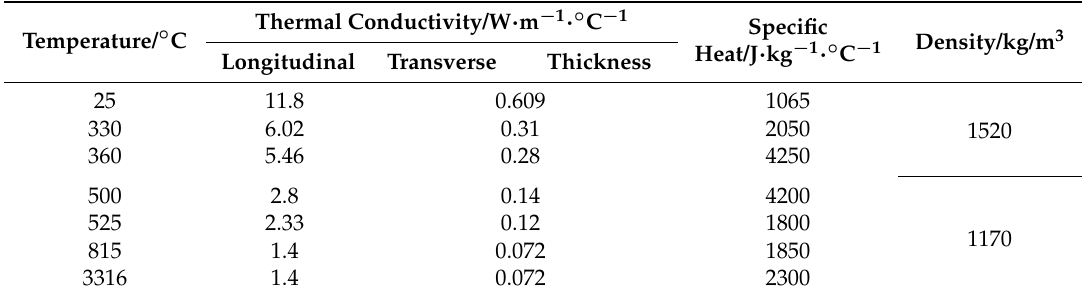
Table 4. Thermal conductivity, specific heat, and density of IM600/133 composite material [29,30]. Temperature/ ◦